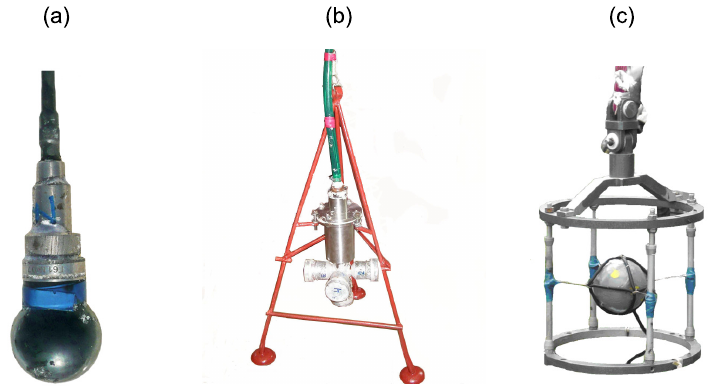
Figure 1. AE sensors: ( a ) hydrophone with integrated amplifier, ( b ) system of directed hydrophones, ( c ) combined